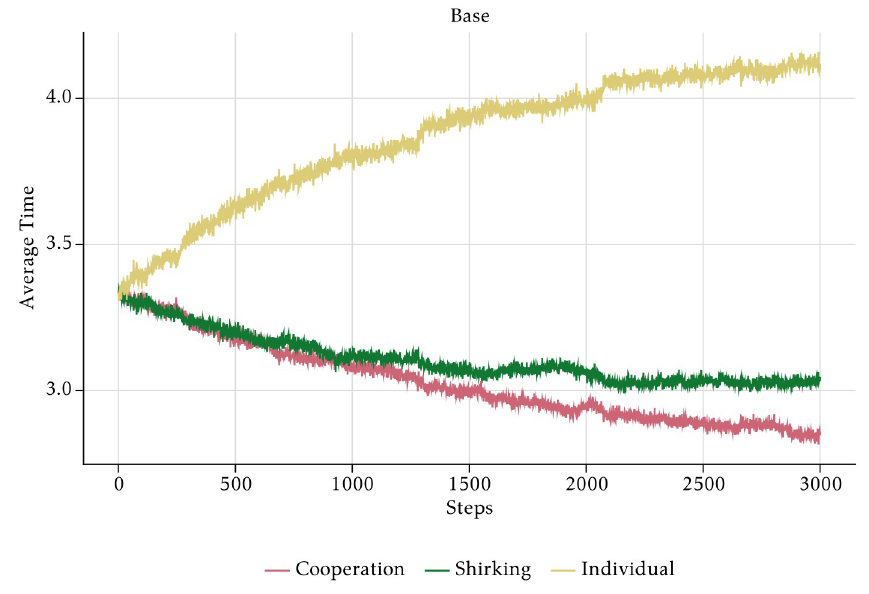
Fig 9. Aggregate average time—Absolute baseline.